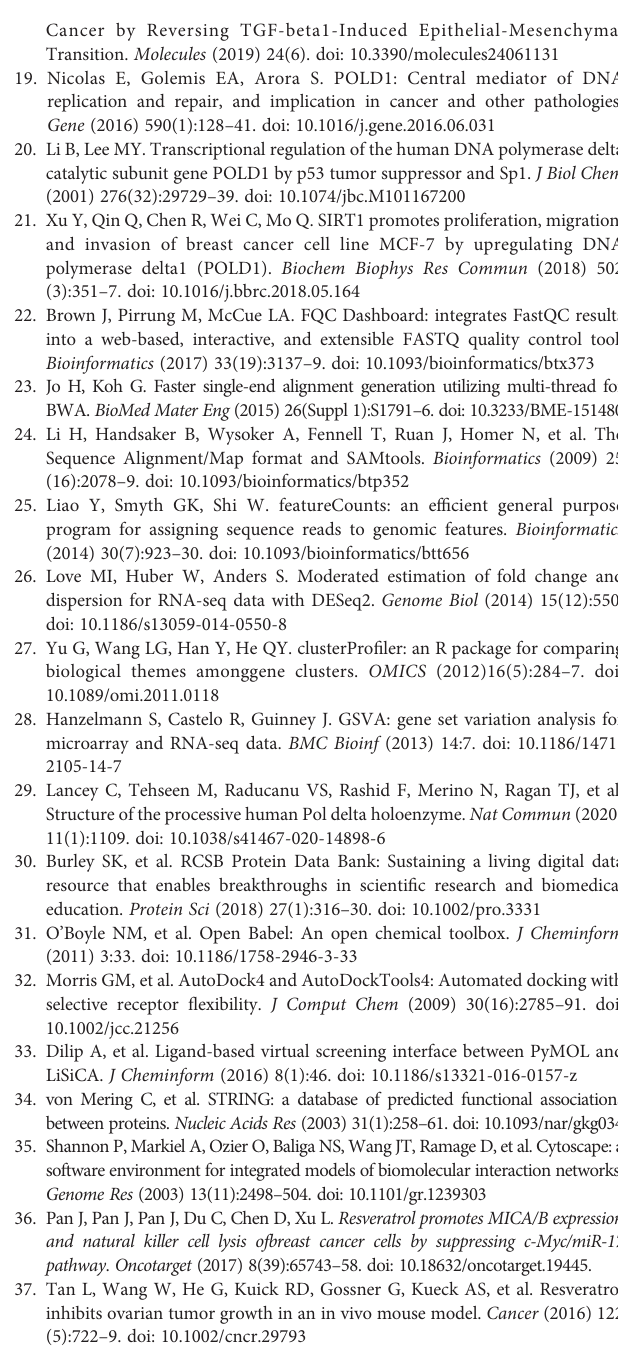
Supplementary Table 1 | The result of CCK8 detection of cell viability after RSV treatment. Supplementary Table 2 | Protein expression of PCNA, BCL-2, Cleaved-PARP1 and Cleaved-Caspase3 after RSV treated. Supplementary Table 3 | WB and qRT-PCR of POLD1 after RSV treated. Supplementary Table 4 | Protein expression and mRNA expression of POLD overexpression.